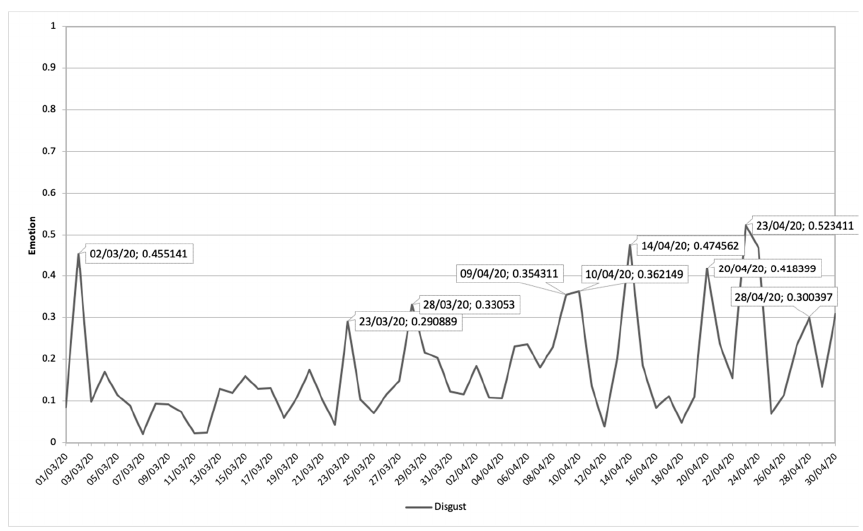
Figure 6. Disgust emotion during the period 1March 2020 until 30 April 2020 related to terms about